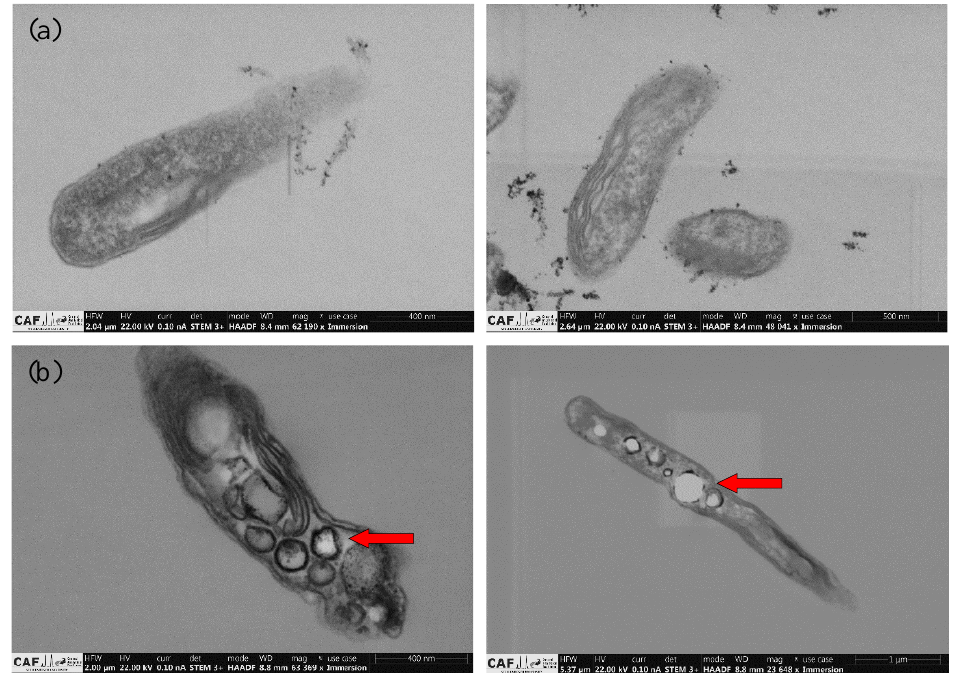
Figure 4. Scanning transmission electron microscopy images for R. palustris cells ( a ) before and ( b ) after experimental runs (PHB granules indicated by red arrows)—images taken by the Central Analytical Facilities (CAF) of Stellenbosch